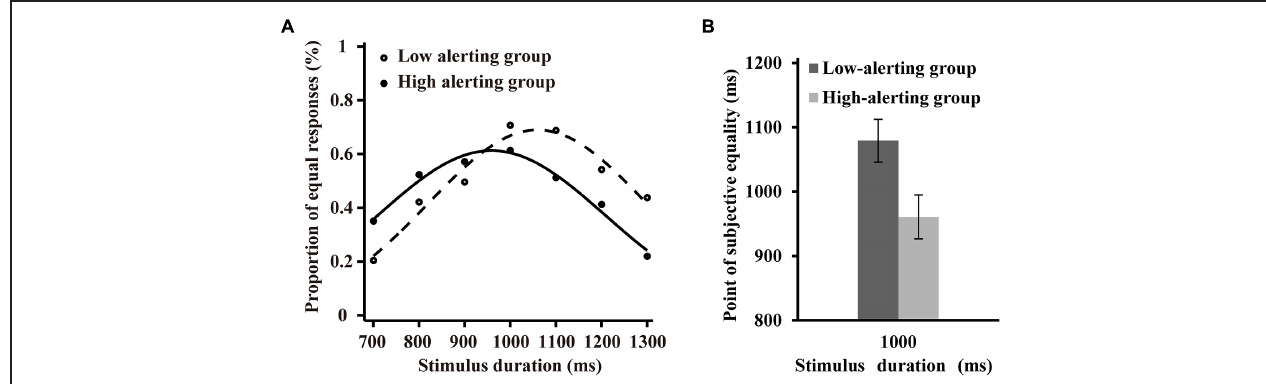
FIGURE 3 | Difference between the high alerting efficiency and low alerting efficiency groups in the time generalization task. (A) Proportion of “equal” responses plotted as a function of stimulus duration for two groups. The lines are fitted by truncated Gaussian functions. (B) Difference of the point of subjective equality between two